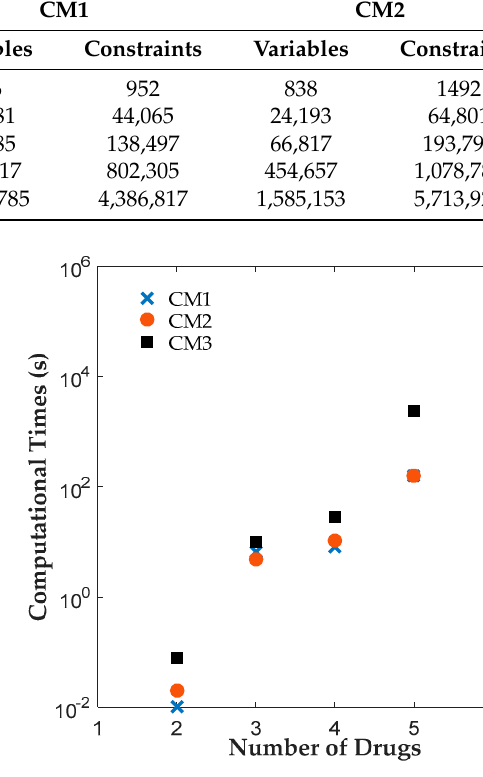
Figure 4. Change in solution times of CM1, CM2 and CM3 with number of drugs.